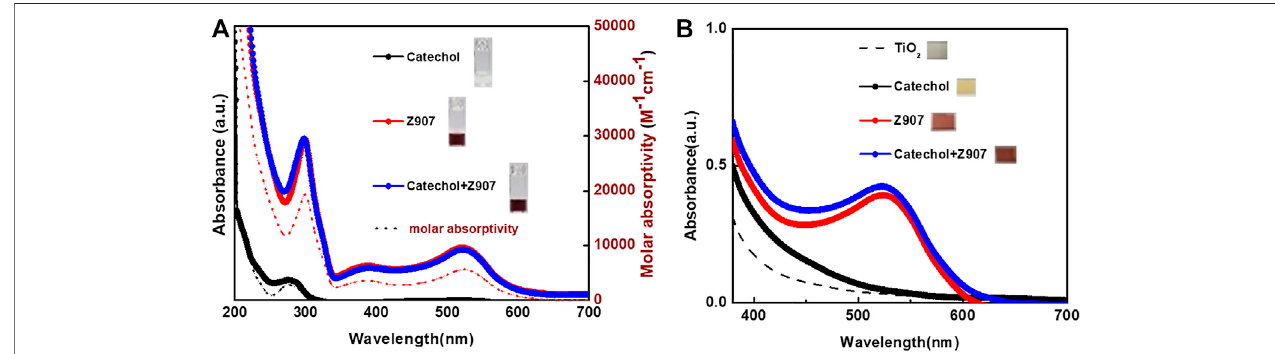
FIGURE 3 | UV-Visible absorption spectra of sensitizers both (A) in ethanol (molar absorptivity axis applies to the dotted lines) and (B) adsorbed on TiO 2 fi lms, respectively. Inserts are